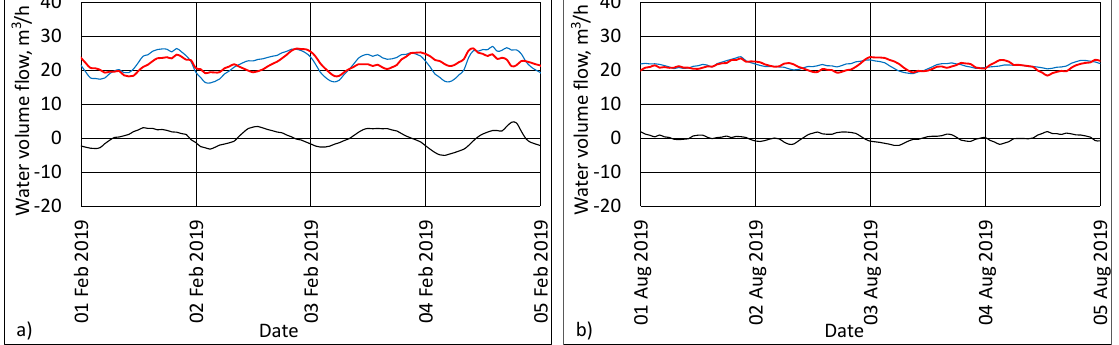
Figure 11. Make-up water flow rate (blue line), water losses (red line), and water volume change per hour (black line) during winter ( a ) and summer ( b ).